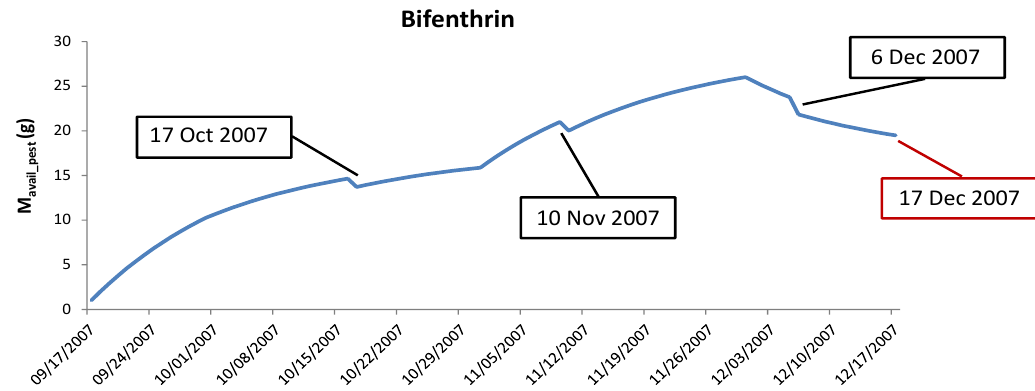
Figure 2. Assessment of bifenthrin M avail for the winter-event 17 December 2007 (F1) (red label). The three-black labeled dates represent the antecedent three rainfall events.